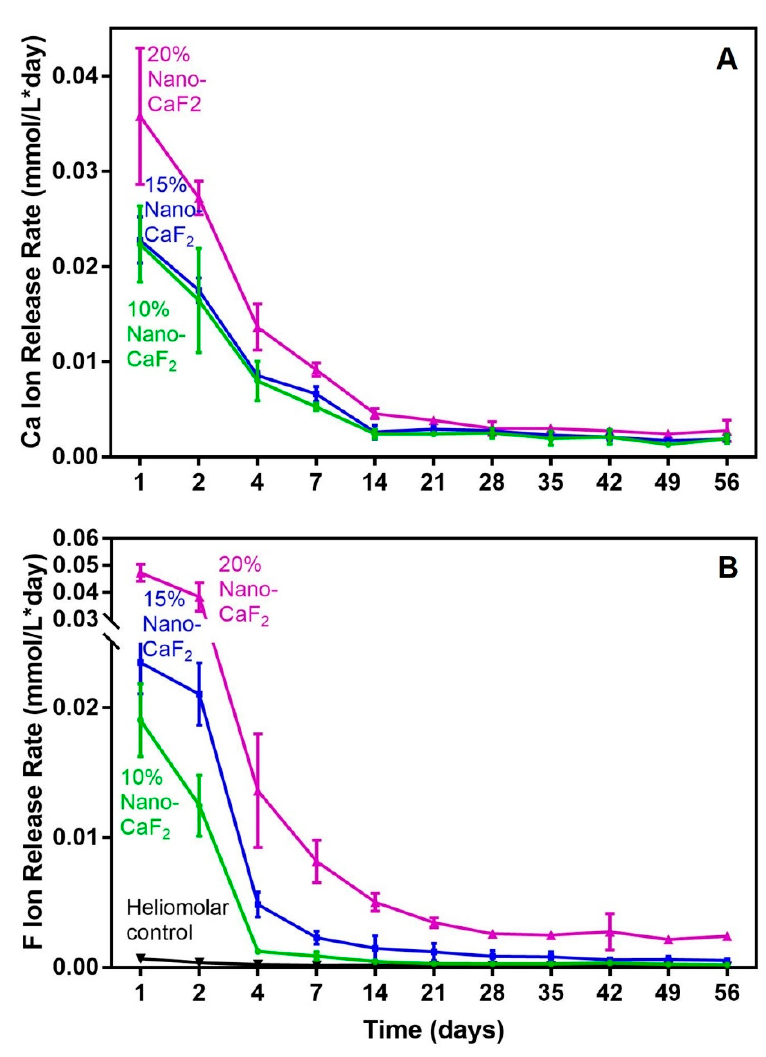
Figure 2. The release of Ca and F ions from CaF 2 composites. ( A ) The Ca ions released from the 20% Nano-CaF 2 was higher than the other composites initially. There was no difference among the three composites at the end time ( p > 0.1). ( B ) The F ions released from the 20% Nano-CaF 2 composite was higher than the other groups. The release from 20% Nano-CaF 2 composite exceeded Heliomolar by nearly 30 folds ( p < 0.05, mean ± SD; n = 6).